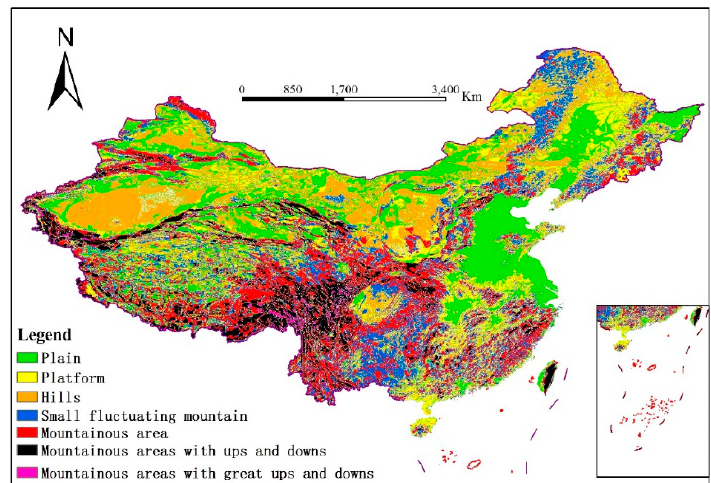
Figure 2. The landforms distribution of China (dataset courtesy by the Data Center for Resources and Environmental Sciences, Chinese Academy of Sciences (RESDC)).